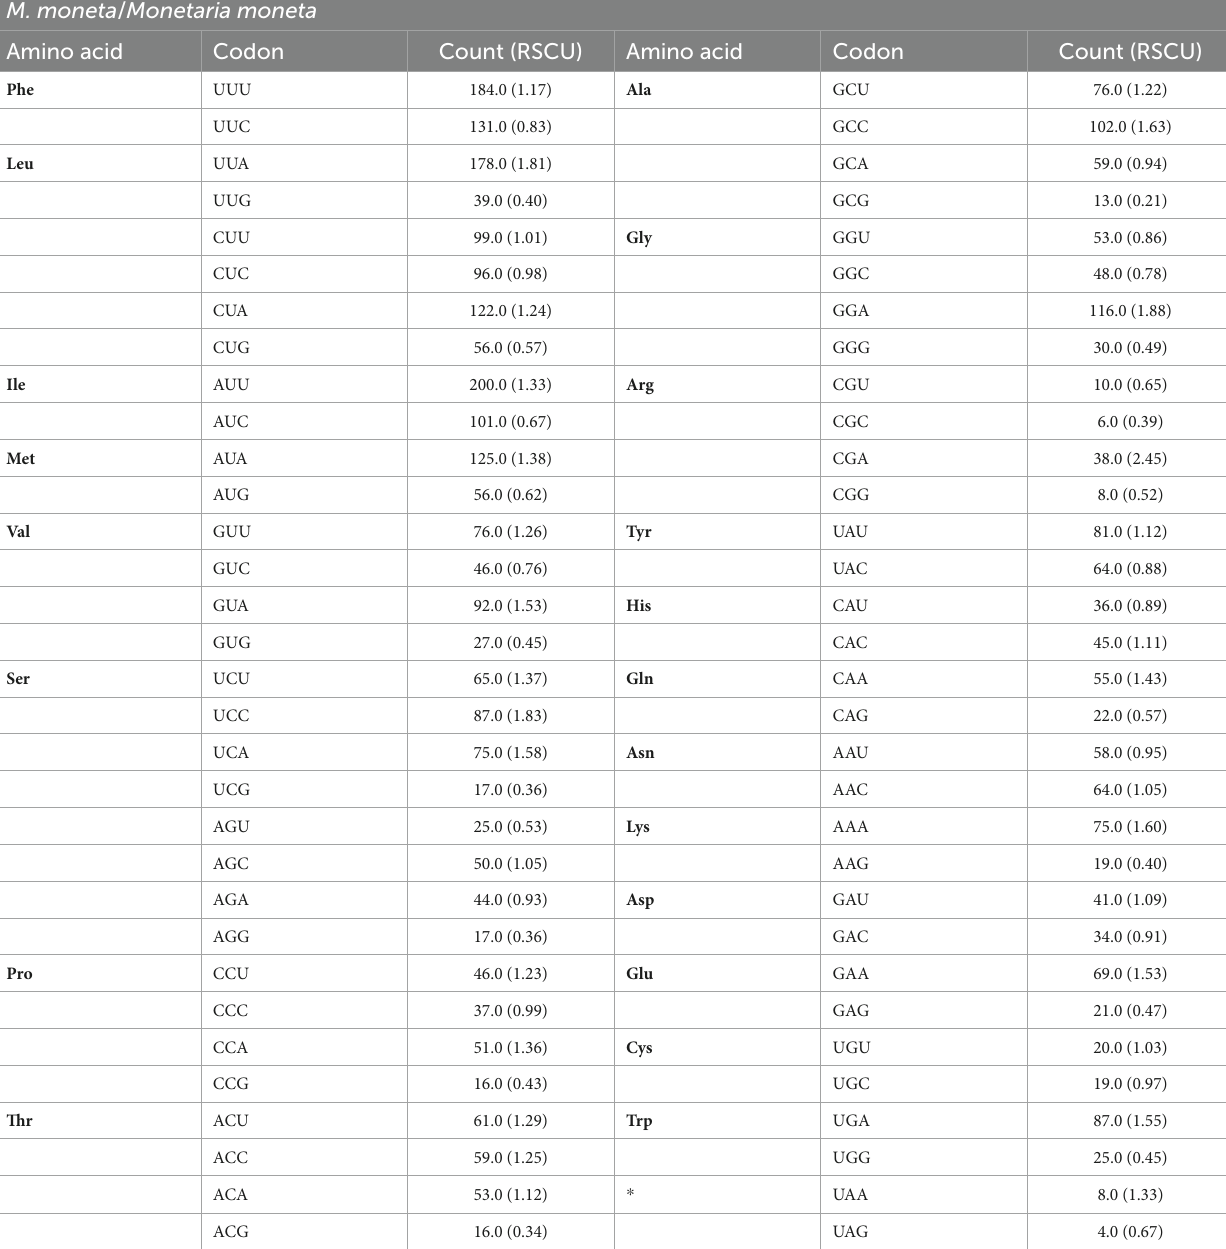
TABLE 4 Codon and relative synonymous codon usage (RSCU) of 13 PCGs in the mt genomes of M. monetab ( Cmm ), N. helvola ( Cnh ), P. gracilis ( Cpg ), M. arabica ( Cmar ), N. miliaris ( Cnm ), L. vitellus ( Clv ), N. erosa ( Cne ), E. onyx ( Ceo ), E. caurica ( Cec ), and M. caputserpentis ( Cmc ). M. moneta / Monetaria